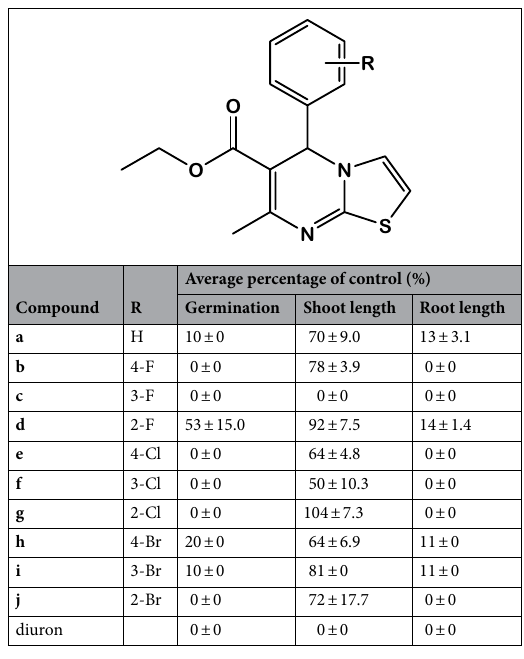
Table 1. Inhibitory effect (mean ± standard error) of thiazolo[3,2-a]pyrimidine carboxylate derivatives at 500 mg/L on germination, shoot length and root length of Eleusine indica after 7 days. of treatment a